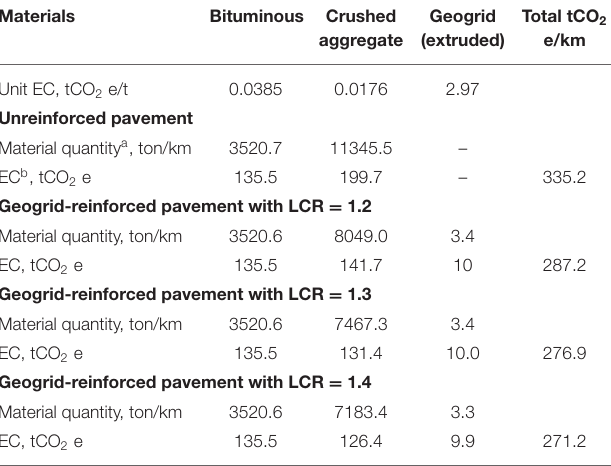
TABLE 6 | EC values for unreinforced and reinforced pavements with granular layer reduction in reinforced cases.